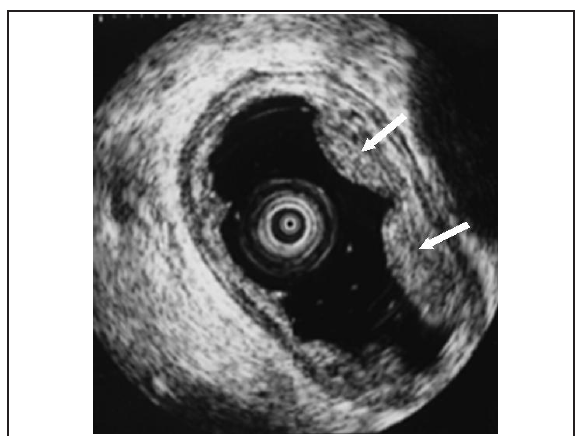
Fig. 2: Endoscopic ultrasound revealed the submucosal nature of the tumor, which was isoechoic (bold white arrow), without spread into muscularis